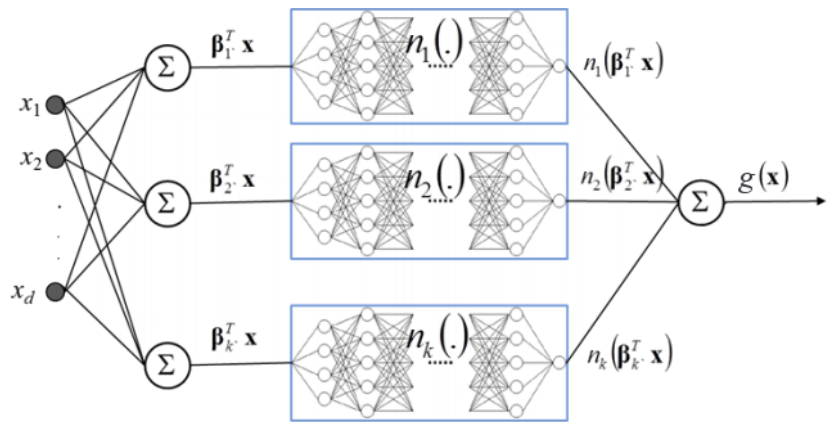
Figure A1. A general diagram of an XNN with three metalayers: the bottom combination layer with K linear ∑ j β k , j x j hidden units, the middle metalayer with with K hidden and separate n k ridge functions, and the output combination layer that generates g XNN ( X ) predictions. Figure adapted from Vaughan et al.